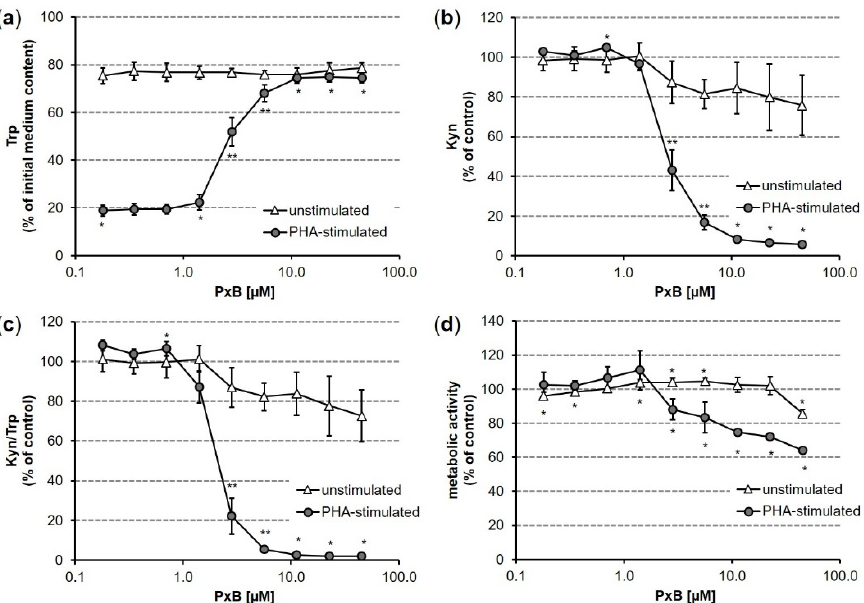
Figure 3. Comparison of ( a ) Trp, Kyn and ( b ) Kyn/Trp concentrations in the supernatants of unstimulated (light grey) and PHA-stimulated (dark grey) PBMC after 48 h of incubation. ** p < 0.005 indicates significance compared to the unstimulated cells. Results shown are mean values ± SEM of 6 independent experiments (6 donors) performed in duplicates.